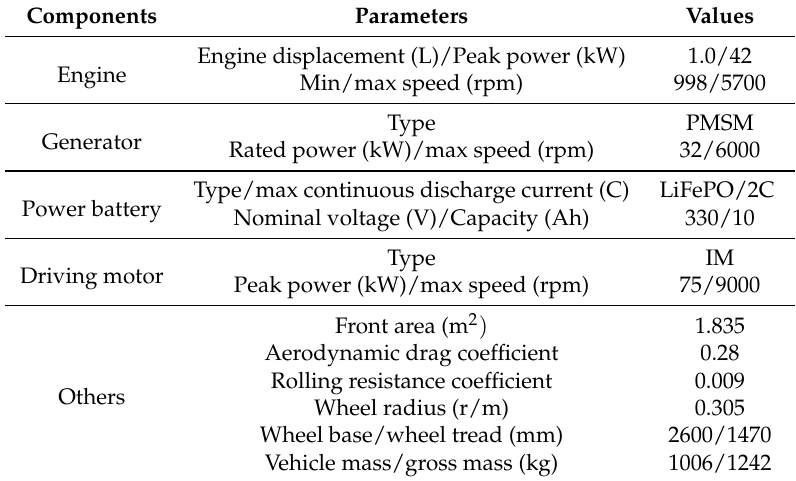
Table 1. Vehicle parameters used in power computation. Permanent magnet synchronous motor: